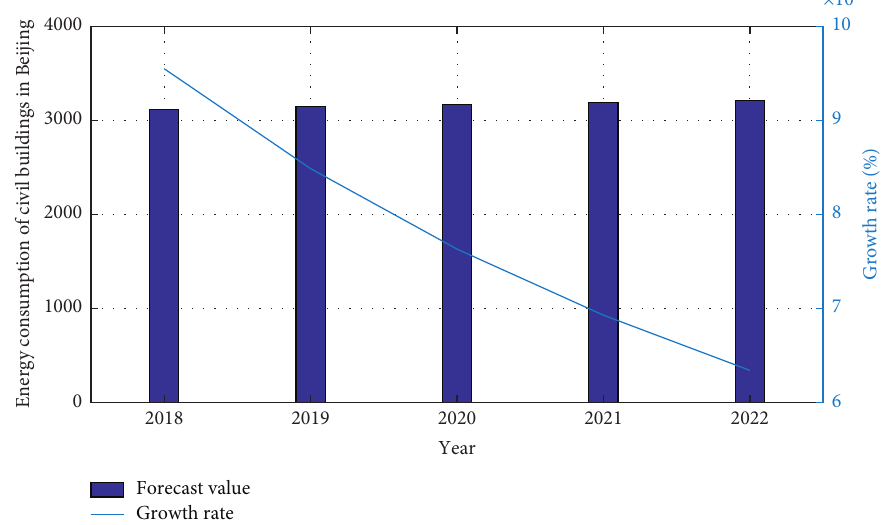
Figure 16: Energy consumption of civil buildings in Beijing over the next 5